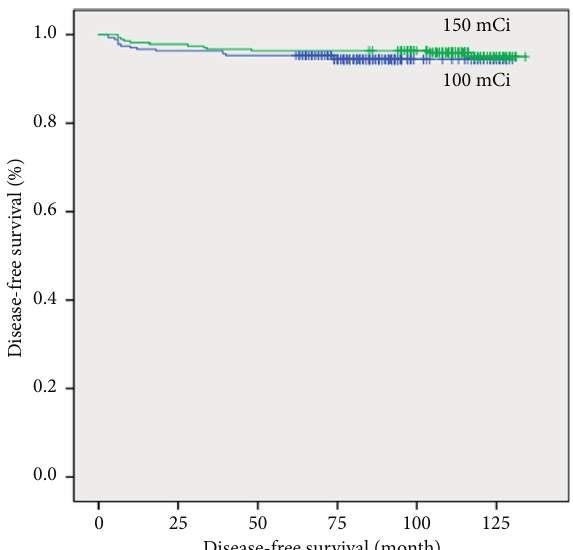
Figure 2: Disease-free survival curves of intermediate-dose (100mCi) and high-dose (150mCi) groups after propensity score matching ( p � 0 . 378).